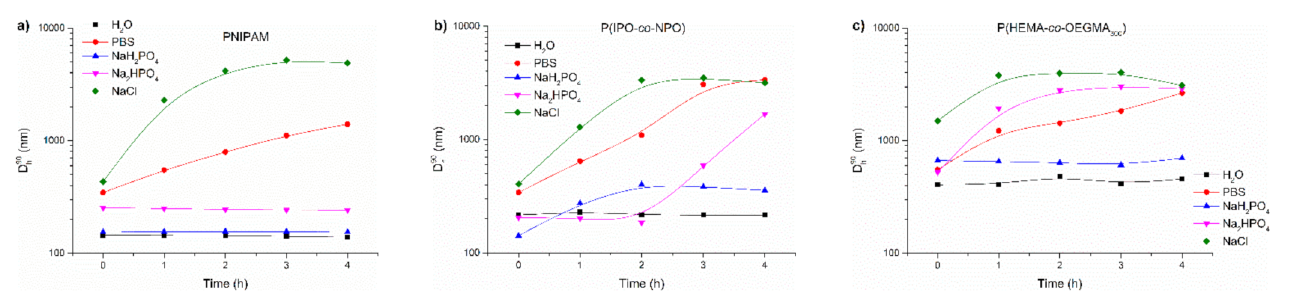
Figure 8. Variations of D h90 with time for abruptly heated solutions of ( a ) PNIPAM, ( b ) P(IPO- co -NPO) and ( c ) P(HEMA- co - OEGMA 300 ). Polymer concentration: 0.5 g/L; abrupt heating at 70 ◦